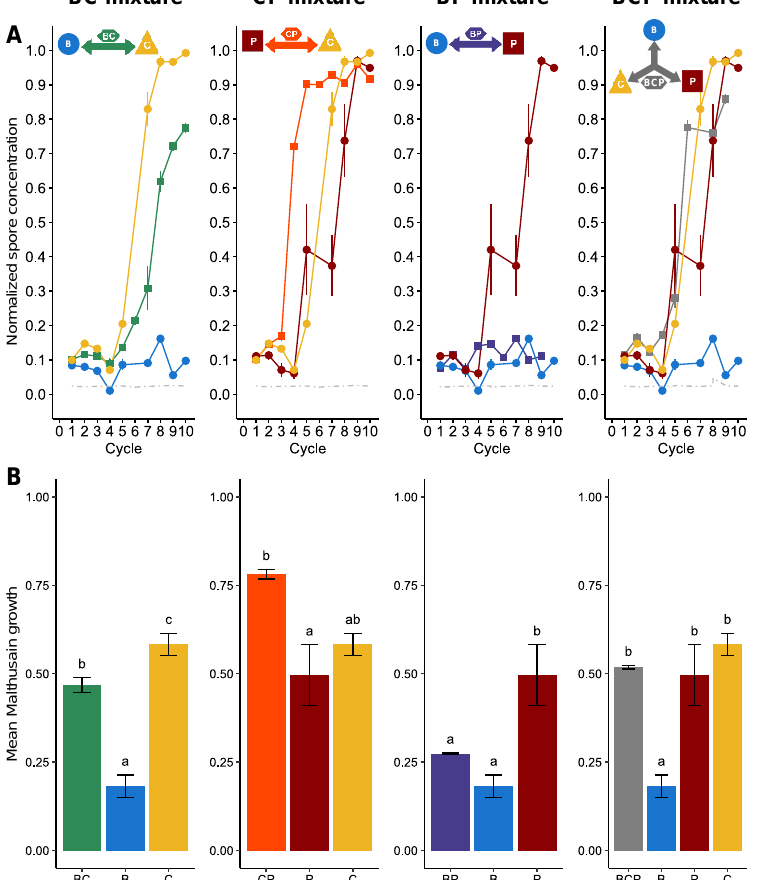
Figure 1. Dynamics of resistance evolution in the lines selected at 90% treatment efficacy. Each column represents the results for a pair of fungicides used alone or as a mixture, at their efficient dose, as explained in the pictograms at the top. B: benzovindiflupyr (SDHI), C: carbendazim (benzimidazole) and P: prothioconazole-desthio (DMI). ( A ) The normalised spore concentration is the spore concentration observed at the end of a cycle relative to that in the control line (i.e., a susceptible population not exposed to fungicides). ( B ) Mean Malthusian growth. Results are normalised against the Malthusian growth of the control (histogram bars) and are presented with their standard deviations (upper and lower lines). Different letters indicate significant differences between groups ( P < 0.05).